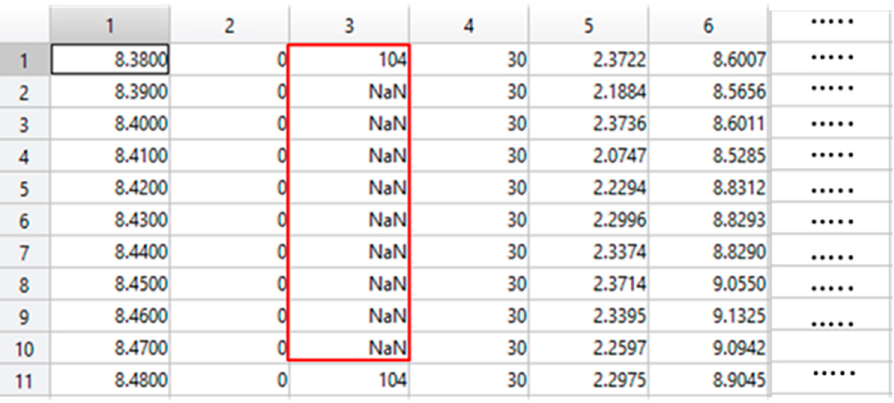
Figure 3. An example of window selection to impute missing values.